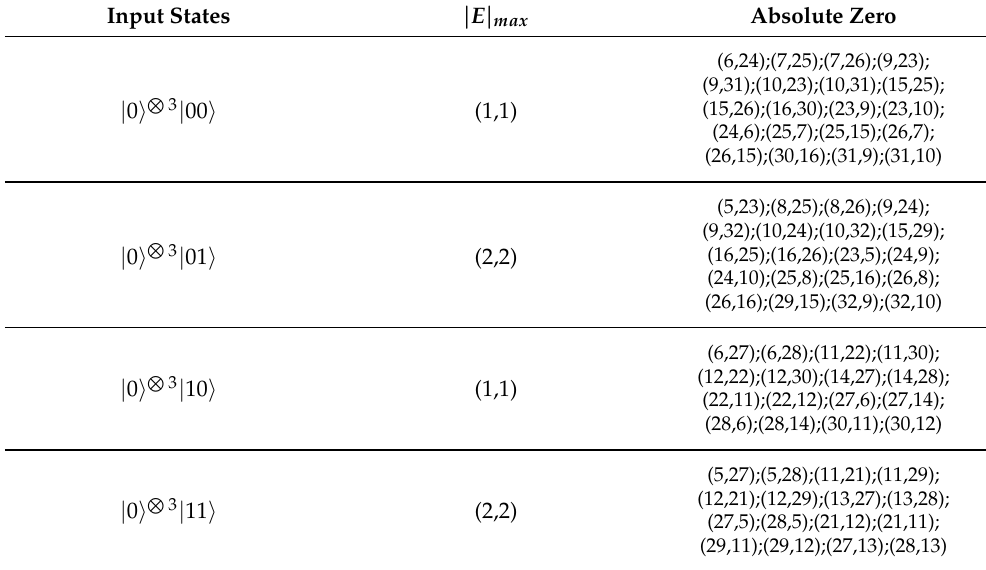
Table 1. Coordinates of elements with the maximum and zero values in the real part of density matrices for the four input states. Designate | 00000 (cid:105)(cid:104) 00000 | as (1,1) and | 11111 (cid:105)(cid:104) 11111 | as